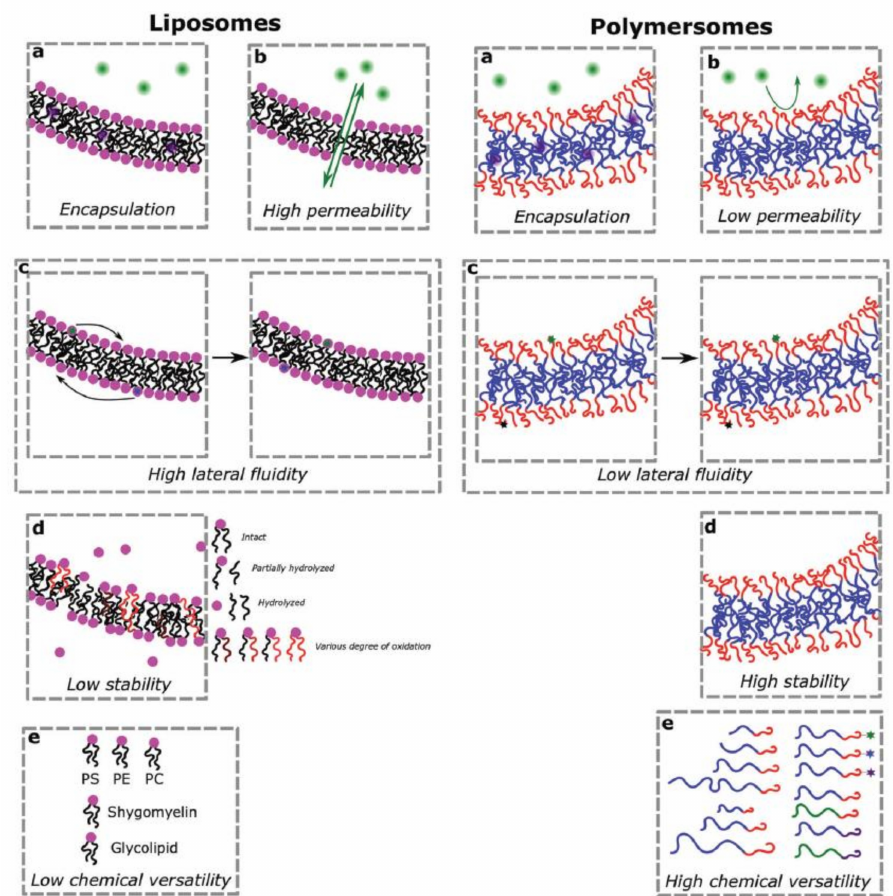
Figure 3. Properties comparison between liposomes and polymersomes [2]. Reproduced by permission of The Royal Society of